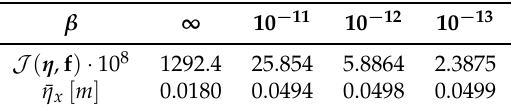
Figure 4. Controlled case with velocity profiles v and streamlines in the liquid ( left ) and displacement η in the solid ( center ). Force vectors f in black and magnitude in colors ( right ). Table 2. Objective functional and average x -displacement over the controlled region Ω d computed J with no control ( β = ∞ ) and different β